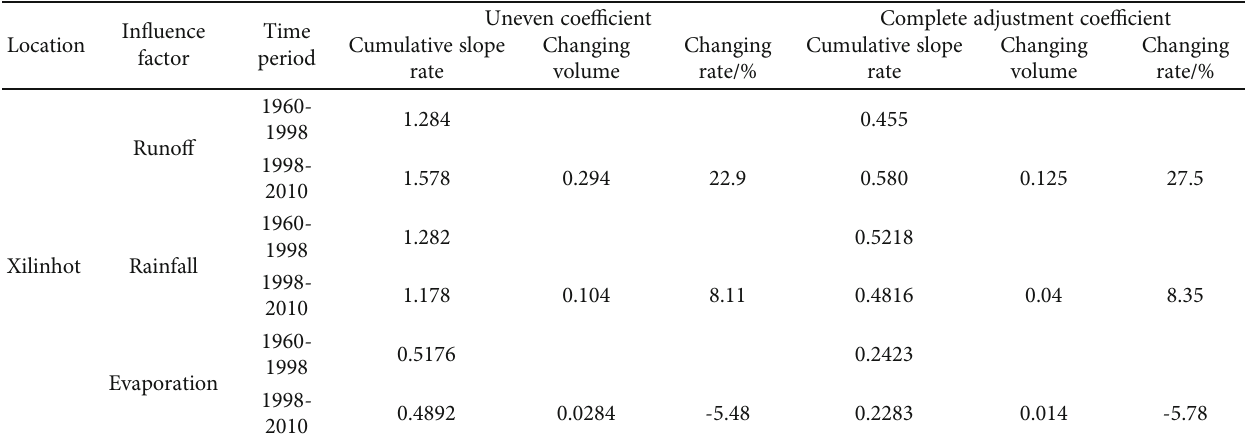
Table 3: Change ratio of the slopes of accumulative characteristic values of runo ff , precipitation, and potential evaporation seasonal distribution in1960-2010.